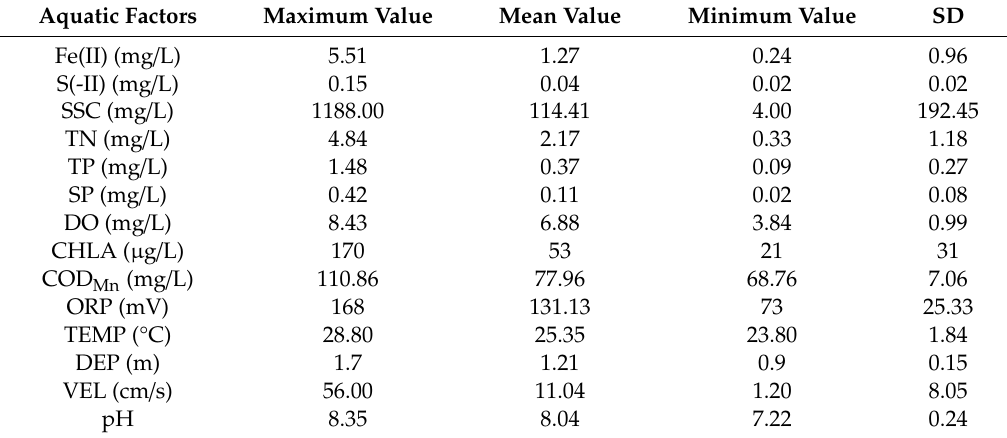
Table 1. Statistics of observations ( n =